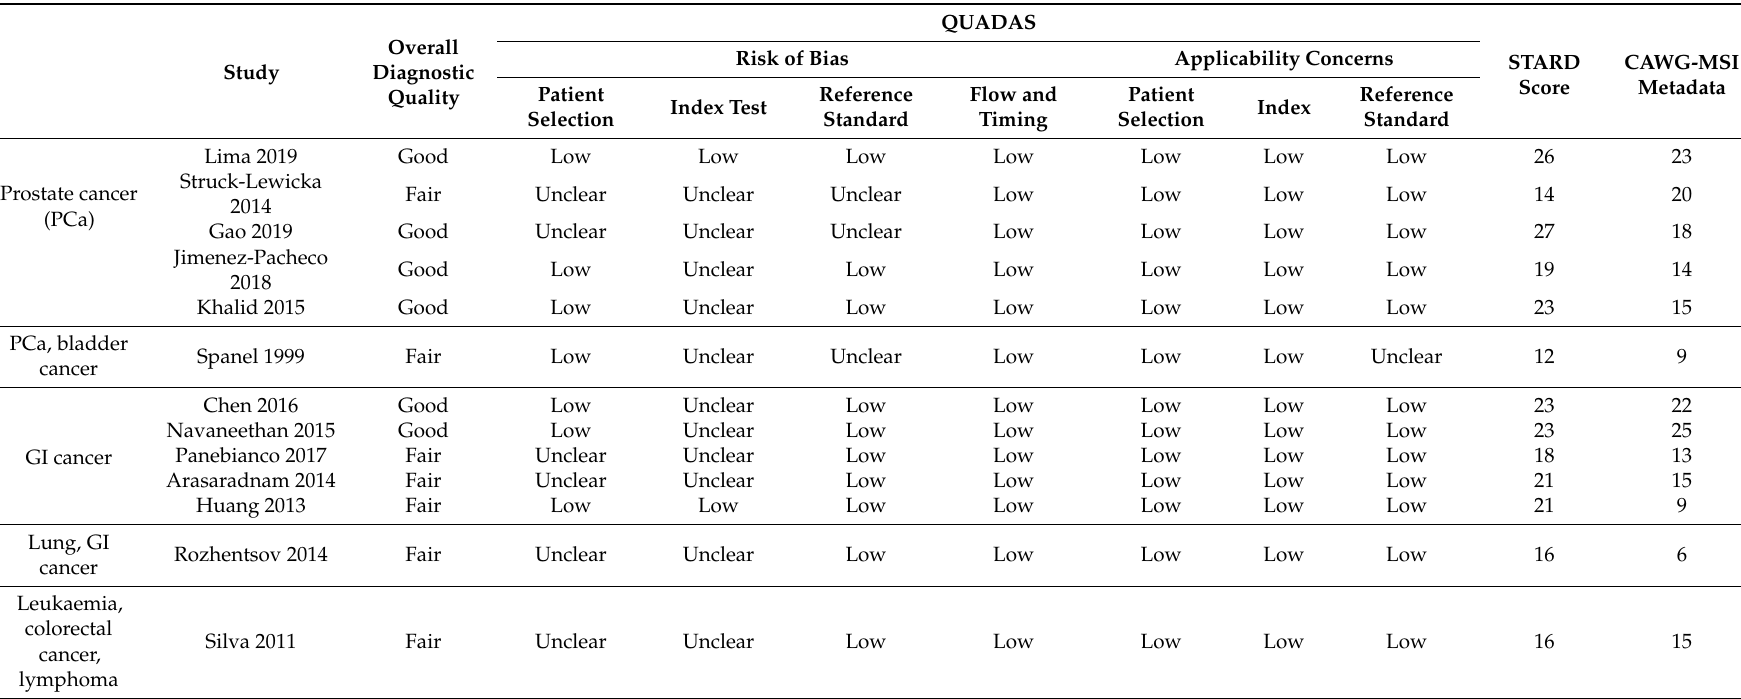
Table 2. Quality assessment with Standards for Reporting of Diagnostic Accuracy studies (STARD), Quality Assessment of Diagnostic Accuracy Studies-2 (QUADAS-2), and